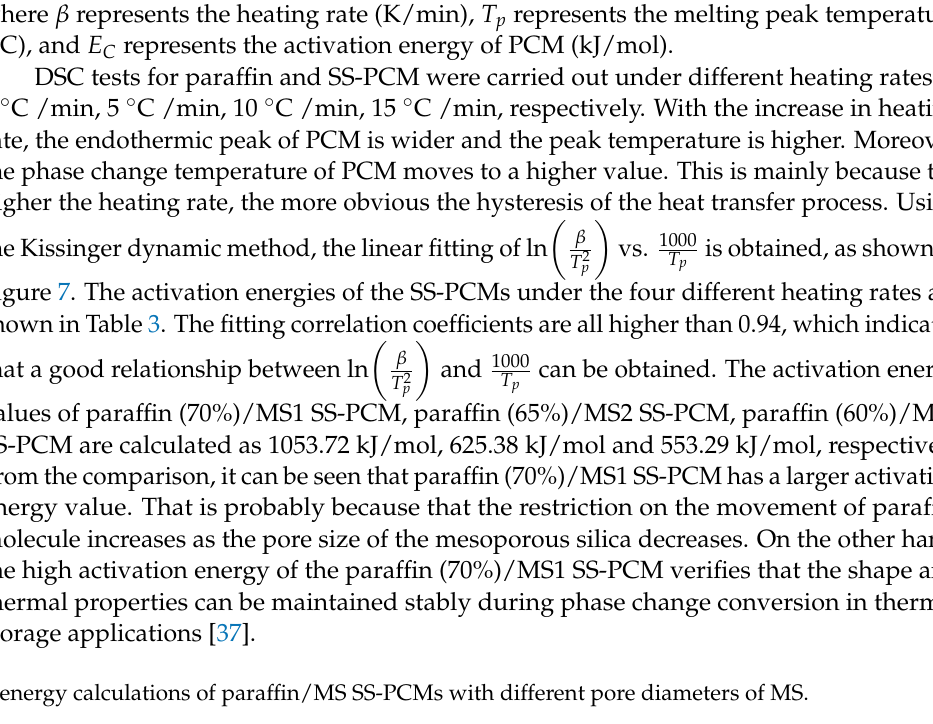
Table 3. Activation energy calculations of paraffin/MS SS-PCMs with different pore diameters of MS.